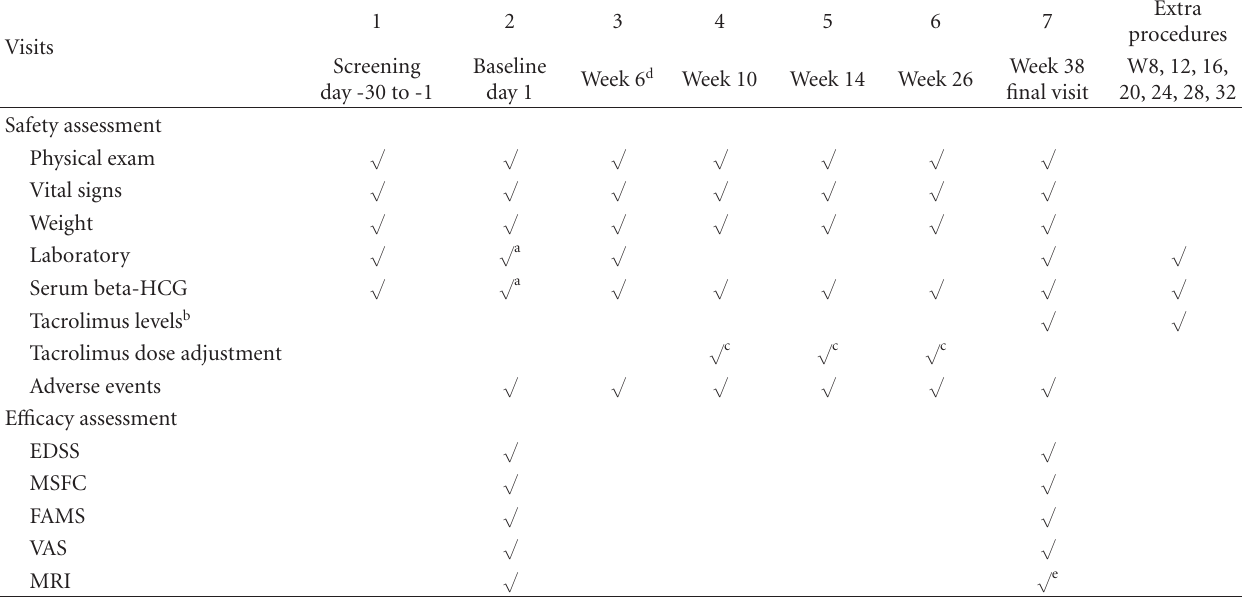
Table 1: Schedule of events for each clinic visit.